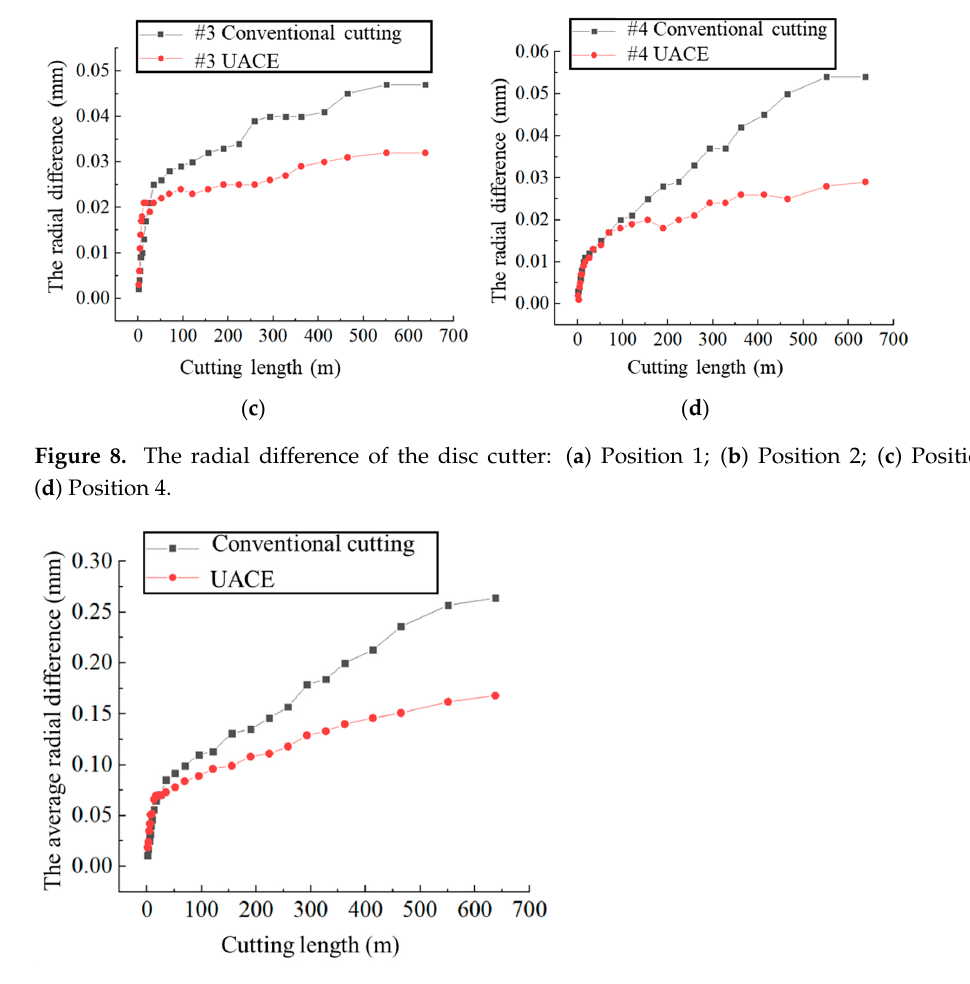
Figure 9. The average radial difference of the disc cutter in conventional cutting experiments and